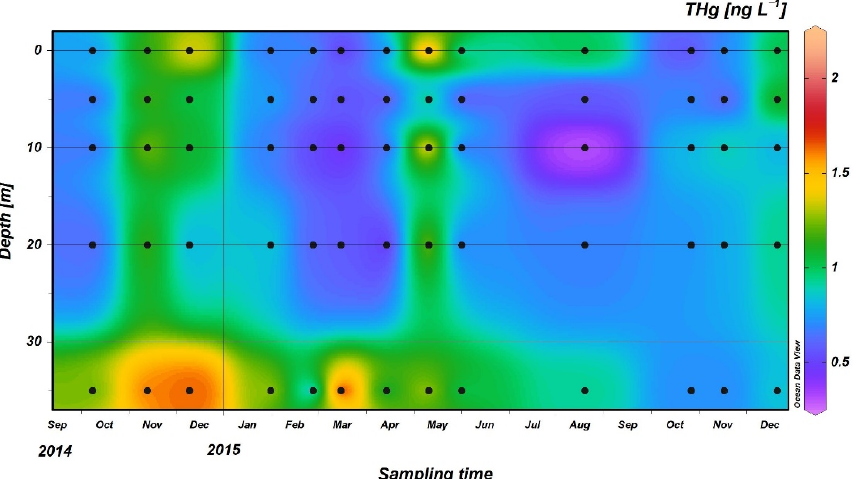
Figure 3. Vertical profiles of total mercury (THg) at station ST101 between October 2014 and December 2015. Adapted with permission from Ref. [33]. Copyright 2019, Elsevier.